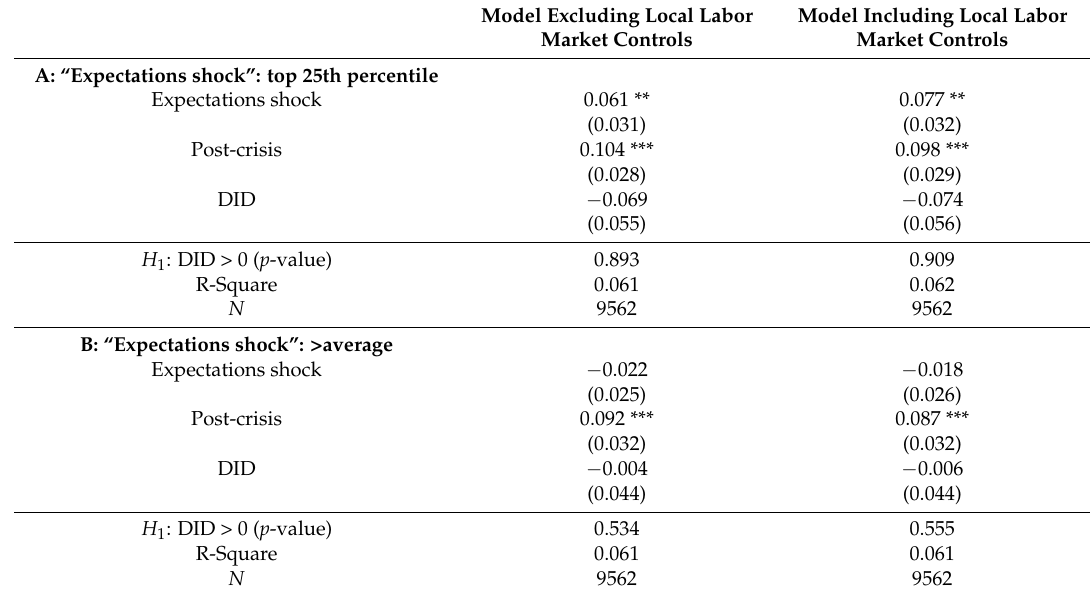
Table 4. The effects of unemployment expectations shocks on mother’s psychological distress score (Kessler 6).